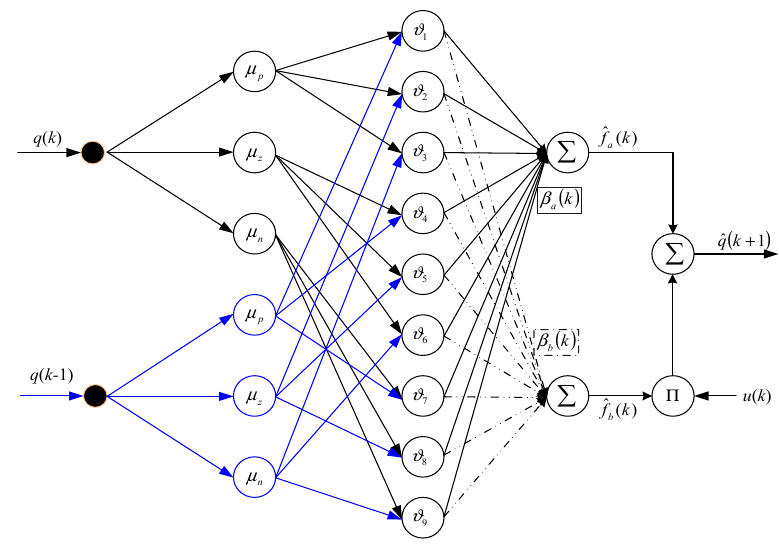
Figure 2. MiFREN identification